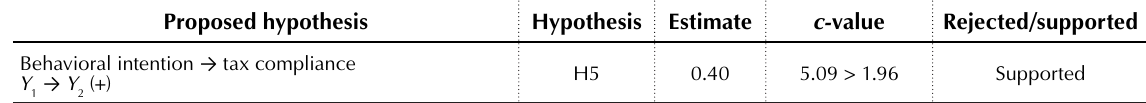
Table 5. Path coefficient for behavioral intention has a positive and significant effect on tax